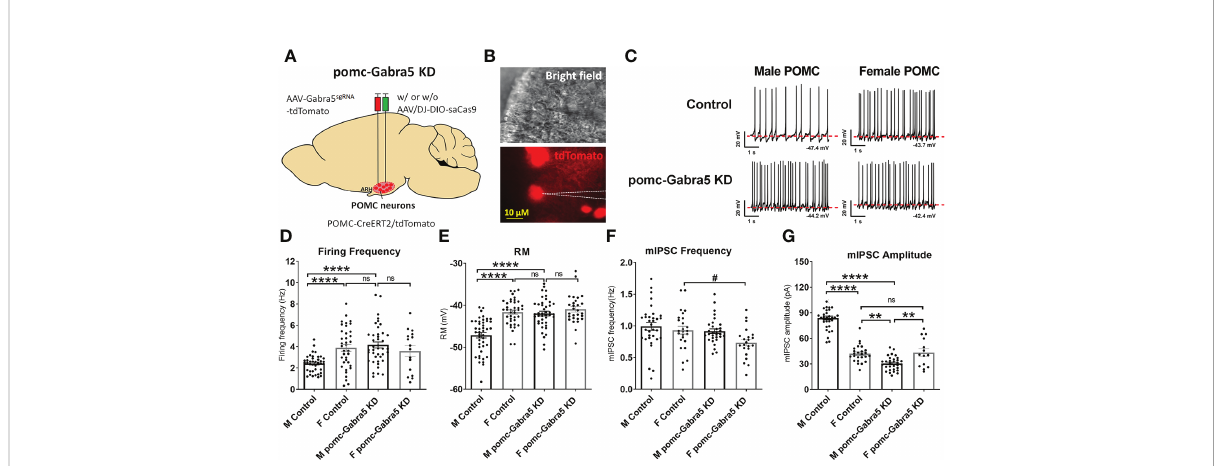
FIGURE 5 Gabra5 de fi ciency increased POMC neuron activities in a sexually dimorphic manner. (A) Generation of pomc-Gabra5 KD mice and controls by stereotaxic injection of AAV-Gabra5 sgRNA -tdTomato virus with or without AAV/DJ-CMV7-DIO-saCas9 virus into the ARH of POMC-CreER T2 mice followed by tamoxifen induction. (B) Bright- fi eld illumination (upper) and fl uorescence for tdTomato (lower) of the recorded POMC neuron in a brain slice. (C) Representative current clamp traces in POMC neurons from chow-fed pomc-Gabra5 KD and control mice 4 weeks after virus injection. (D – G) Average fi ring frequency (D) , resting membrane potential (E) , frequency (F) and amplitude (G) of mIPSC of POMC neurons from chow-fed pomc-Gabra5 KD and control mice 4 weeks after virus injection. Data are presented as mean ± SEM with i ndividual data points. N = 14 – 44 per group. # P < 0.05 in t-tests. **P < 0.01 or ****P < 0.0001 in one-way ANOVA followed by Turkey ’ s tests. ns, not signi fi